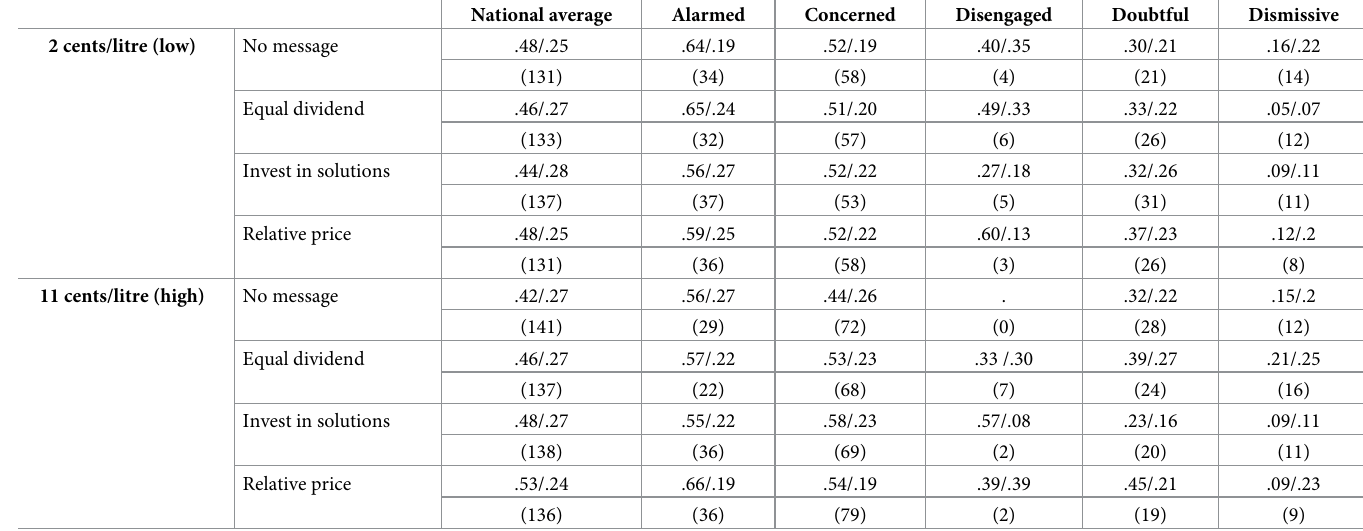
Table 4. Mean level of attitudes toward carbon taxes, by audience segment and experimental treatment (mean/standard deviation, N in